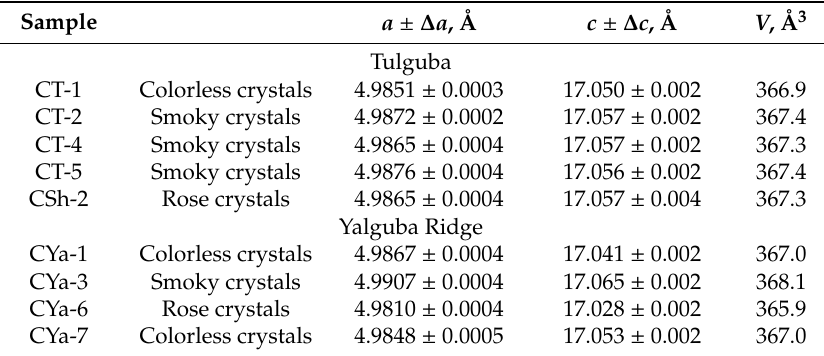
Table 4. Unit cell parameters of calcite from Onega agates.